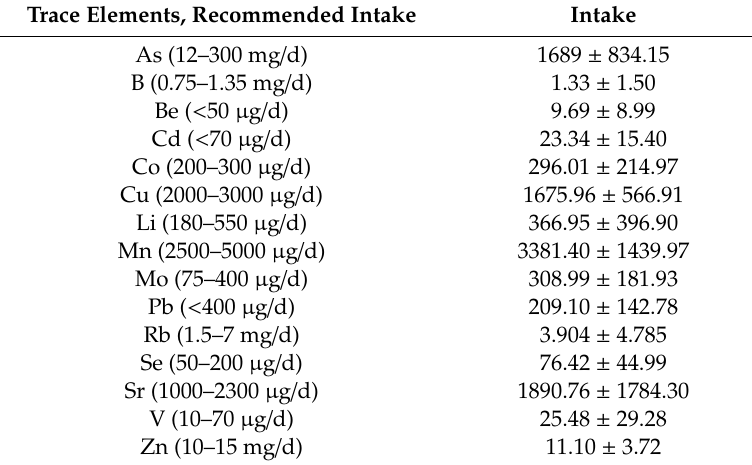
Table 2. Food intake of trace elements in the runners.